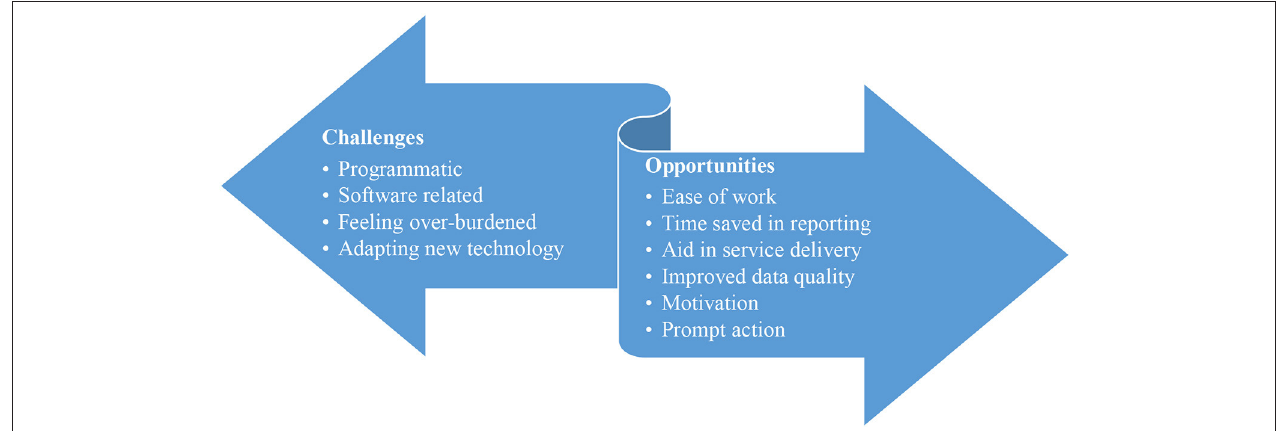
FIGURE 4 | Challenges and opportunities of TeCHO + implementation.